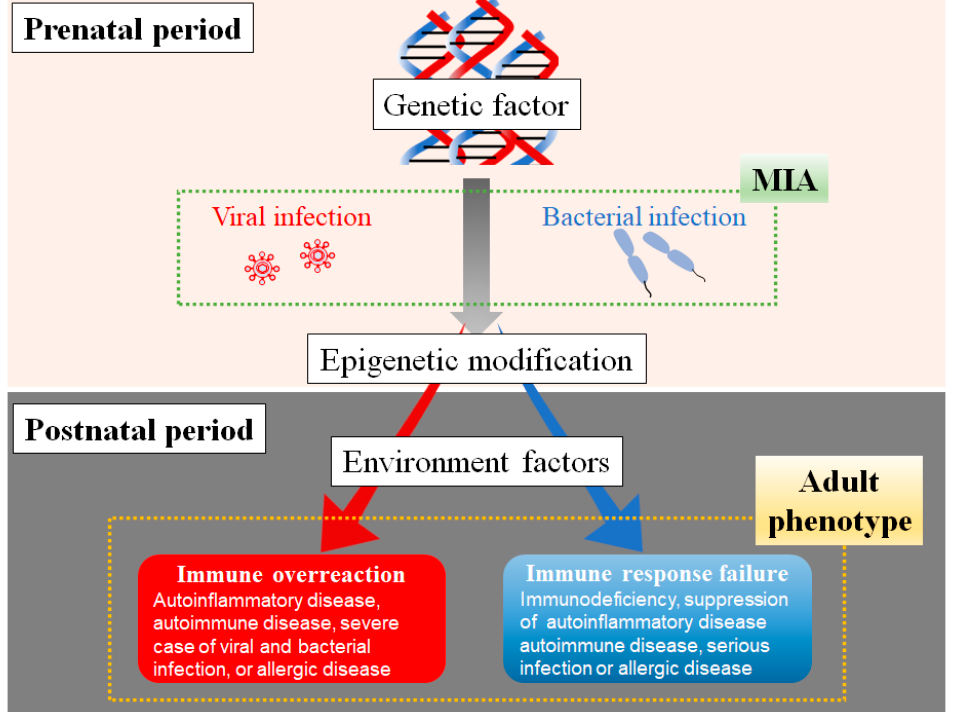
Figure 3. The association of genetic factors, maternal immune activation (MIA), and environmental factors in immune dysfunction after birth.